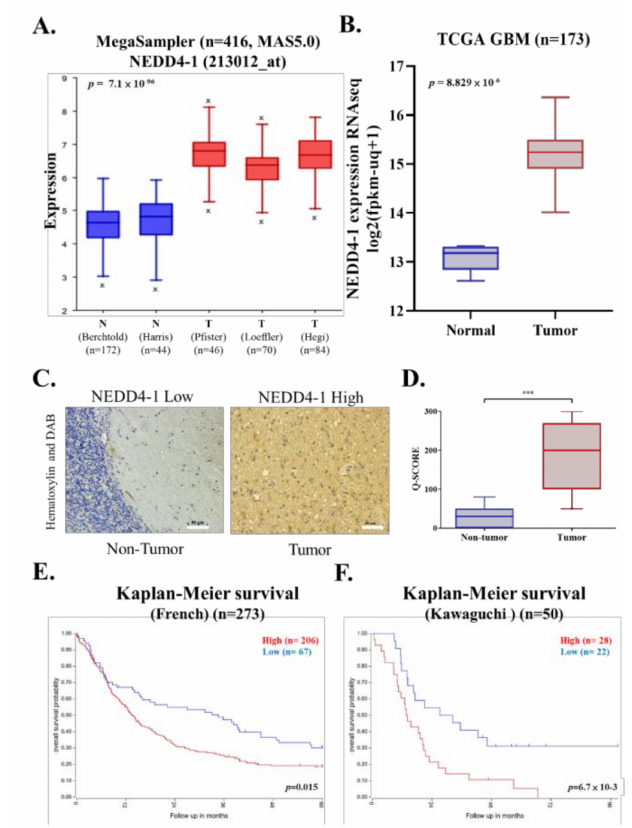
Figure 1. NEDD4-1 is associated with worse prognosis in glioblastoma. ( A ) NEDD4-1 expression evaluated across normal and glioblastoma datasets. ( B ) NEDD4-1 expression levels were evaluated from TCGA-GBM samples are grouped based on tumor and non-tumor counterparts. ( C ) Repre- sentative immunohistochemistry staining of clinical glioblastoma patient tissues. ( D ) Q-Score value comparison between non-tumor and tumor part taken from glioblastoma clinical tissue samples. Kaplan-Meier survival analysis of glioblastoma patients expressing NEDD4-1 was determined using gene correlation analysis by R2: Genomics Analysis and Visualization Platform (http://r2.amc.nl (accessed on 2 July 2021)) of the ( E ) French ( n = 273) and ( F ) Kawaguchi ( n = 50) datasets. *** p <